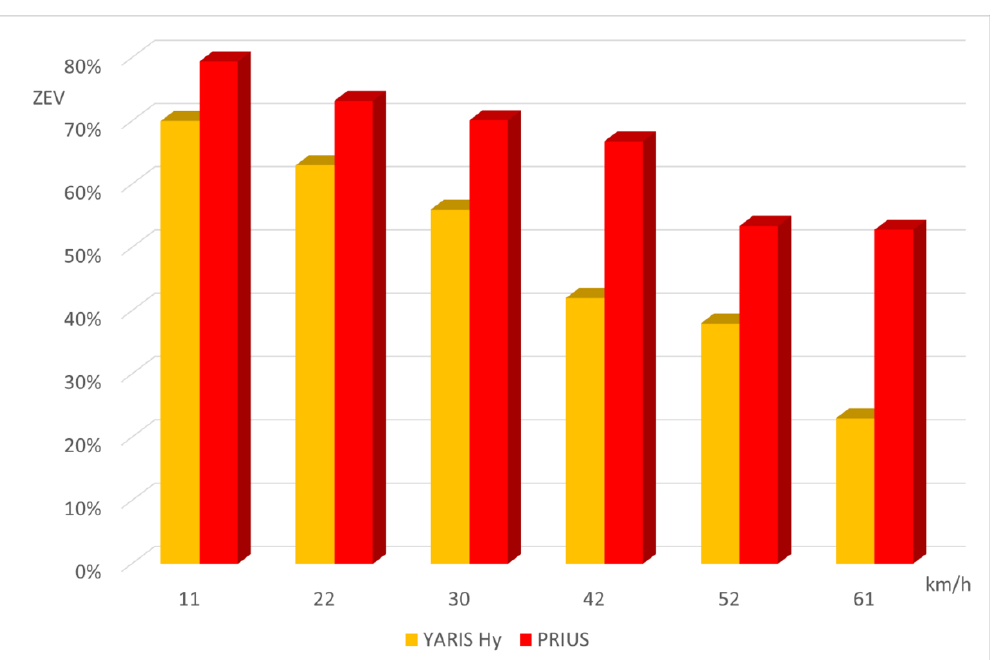
Figure 17. ZEV value of HEV vs. average speed.